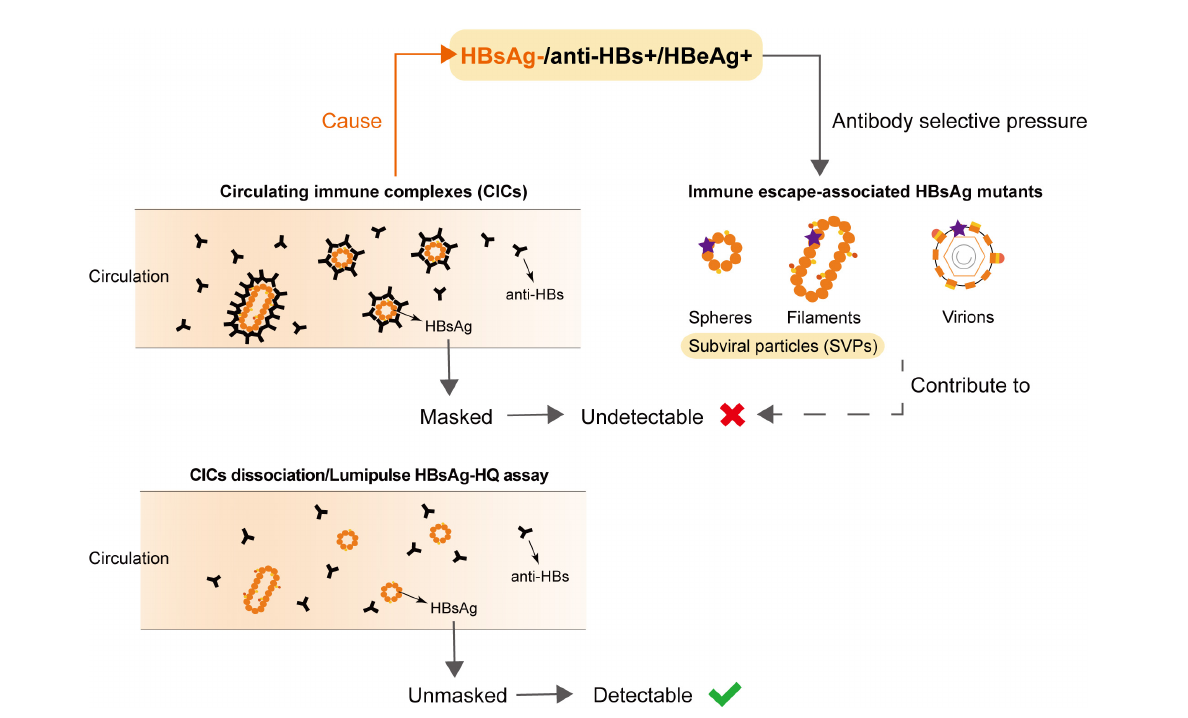
FIGURE3 Undetectable HBsAg in HBsAg-/anti-HBs+/HBeAg+ samples was associated with the circulating immune complexes (CICs) and HBsAg